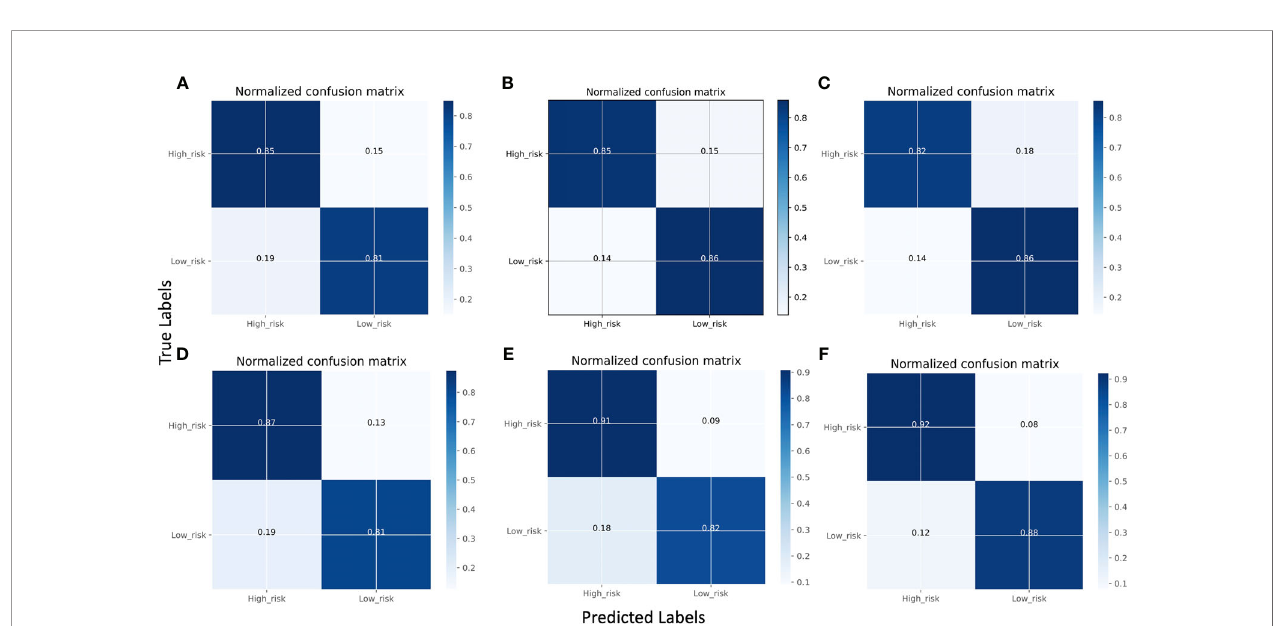
FIGURE 3 | Comparison of model performance using normalized confusion matrices using the validation set. (A) VGG16, (B) Res101, (C) Res50, (D) In_Res, (E) EB5, and (F) X_Cept. The confusion matrix displays the predicted classes on the X-axis and the true classes on the Y-axis, with the color of the diagonal blocks illustrating the closeness of the match between the predicted and the true class. The darker the blue color of the diagonal line, the better the model prediction